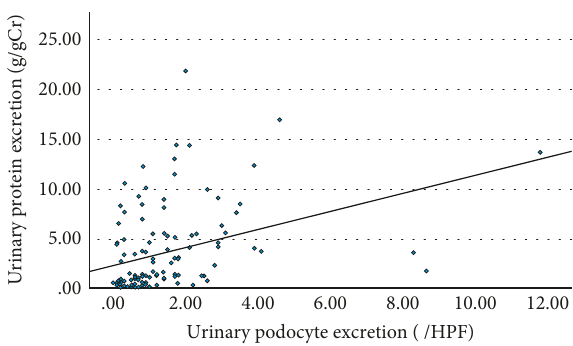
Figure 2: Relationship between urinary podocyte excretion and the amount of proteinuria. r